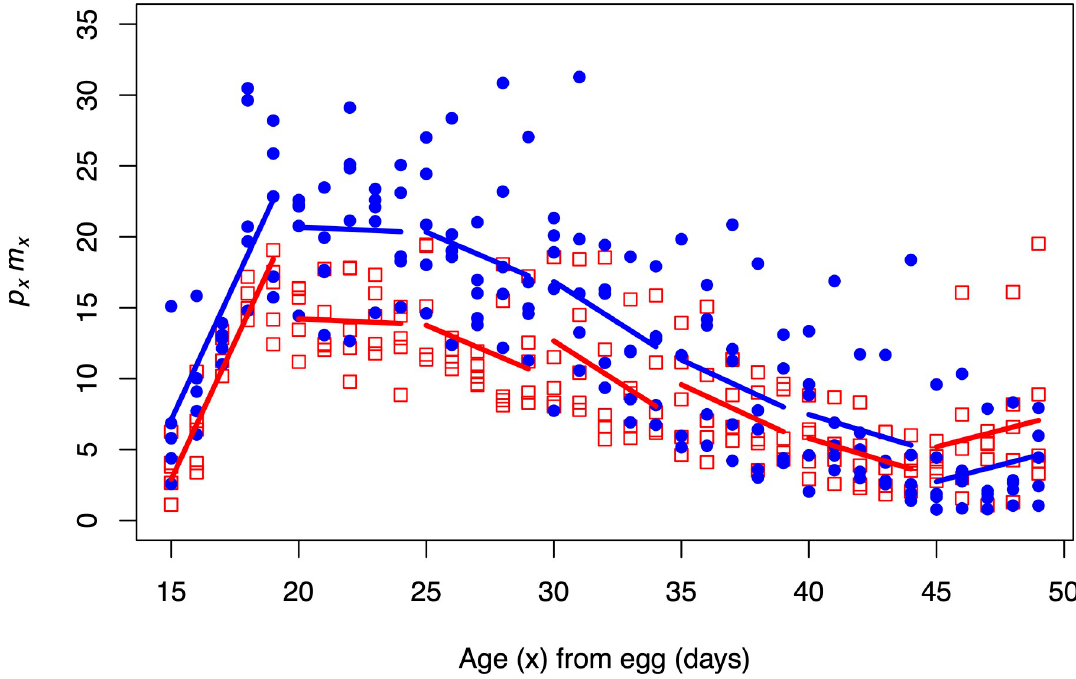
Fig 4. p x m x results in five CO populations exposed to the apple and banana diets. Closed blue circles and solid blue lines represent data and regressions from the banana diet. Open red squares and dotted red lines represent data and regressions from the apple diet. Flies performed significantly better on the banana diet for the second and third age-classes. All other age-classes are not significantly different with respect to their performance on the two